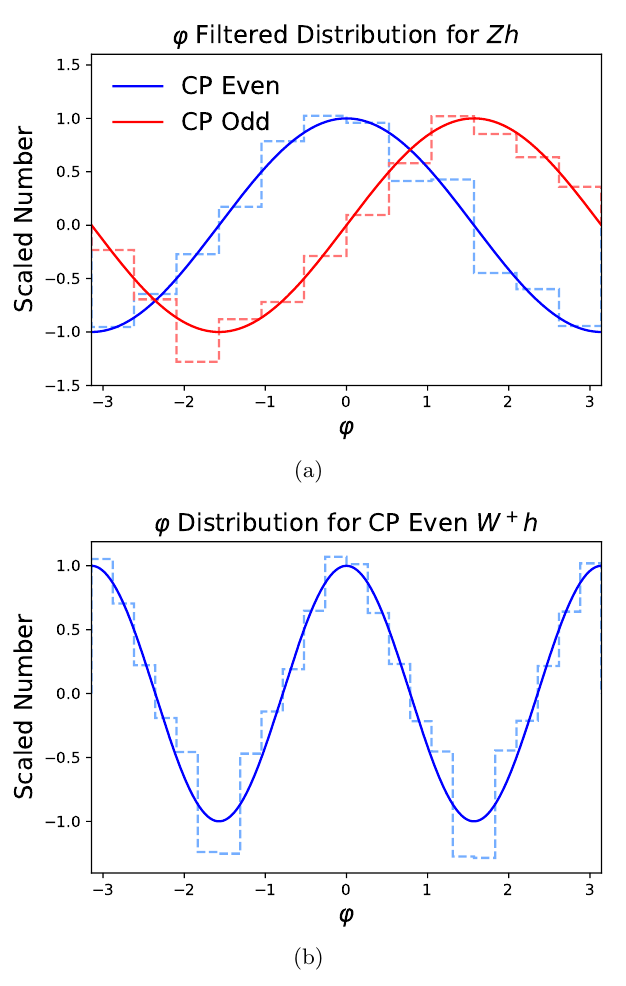
Figure 2 . (a) Weighted ’ -distributions for two di(cid:11)erent Monte-Carlo samples for the Zh mode with the EFT couplings, (cid:20) ZZ and ~ (cid:20) ZZ , respectively, turned on. The events used include showering